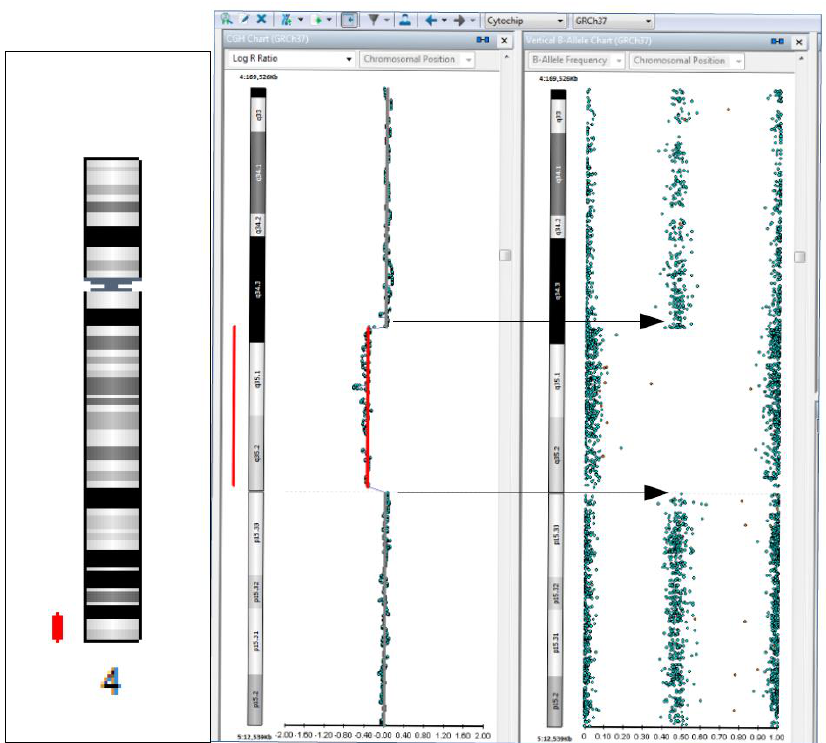
Figure 2. Deletion of 8.5 Mb (in chromosomal regions marked with red lines), with pathogenic signif- icance, detected in the 4q34.3q35.2 region, containing 21 OMIM genes. The deletions comprising the 4q31q35 region have been known and reported in clinical databases and scientific literature as being responsible for phenotypic manifestations corresponding to the 4q terminal deletion syndrome (or distal monosomy 4q), including craniofacial anomalies, dysmorphic features, intellectual disabilities, developmental delay, ocular, cardiac, genitourinary malformations, and pelvic/limb dysmorphism (ORPHA:96145) [4,5]. Based on all this evidence, both 3p26.3p24.3 duplication and 4q34.3q35.2 deletion detected in the patient’s sample were classified as pathogenic CNVs [4], and contributed to the patient’s phenotypic expression; their simultaneous presence in the case of a single patient has not been reported until now, to our knowledge. The two detected genomic changes